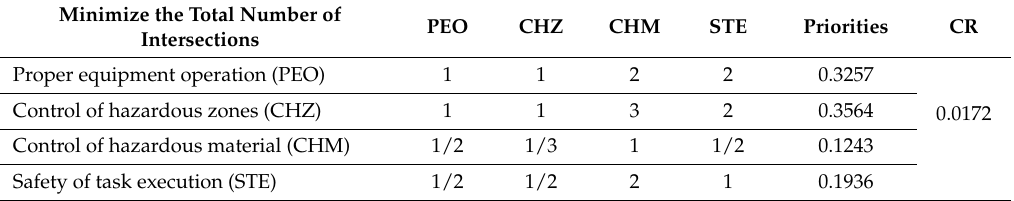
Table 4. Pairwise comparisons of safety with respect to resource travelling